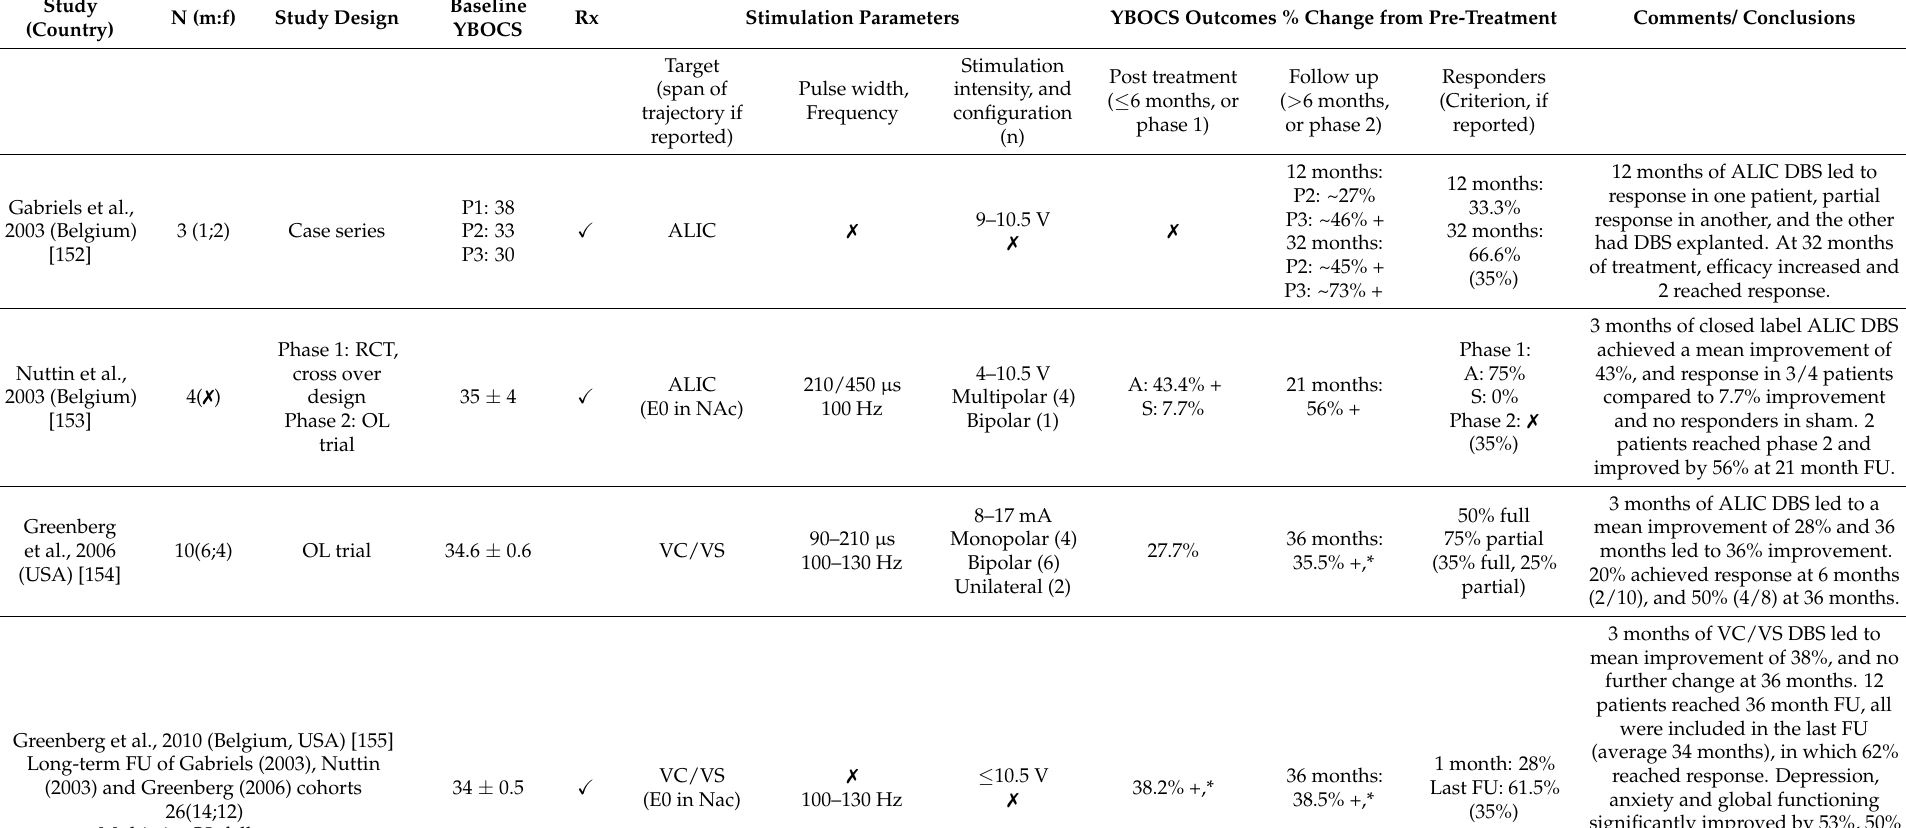
Table 12. Summary results of deep brain stimulation for obsessive compulsive